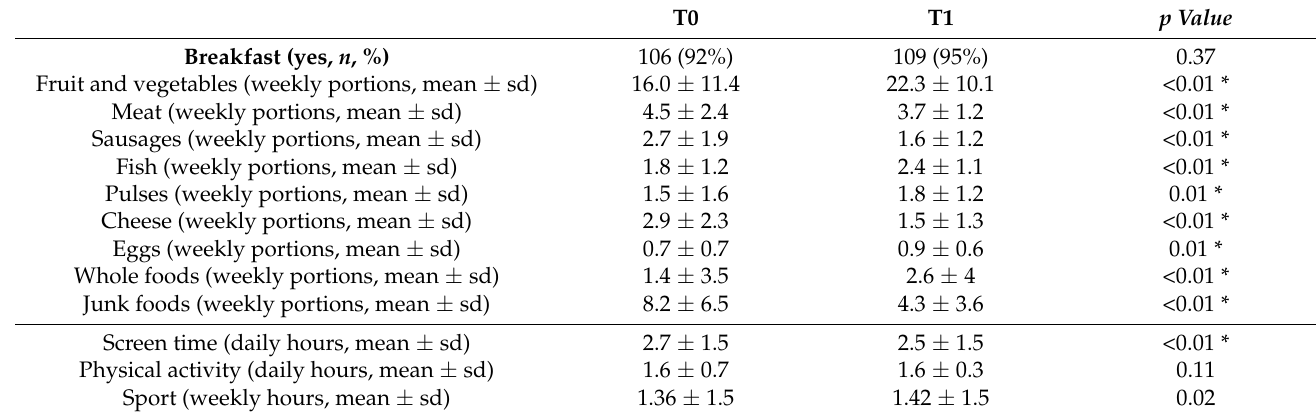
Table 2. Dietary and lifestyle habits of the study population at baseline (T0) and after six months of nutritional and lifestyle intervention